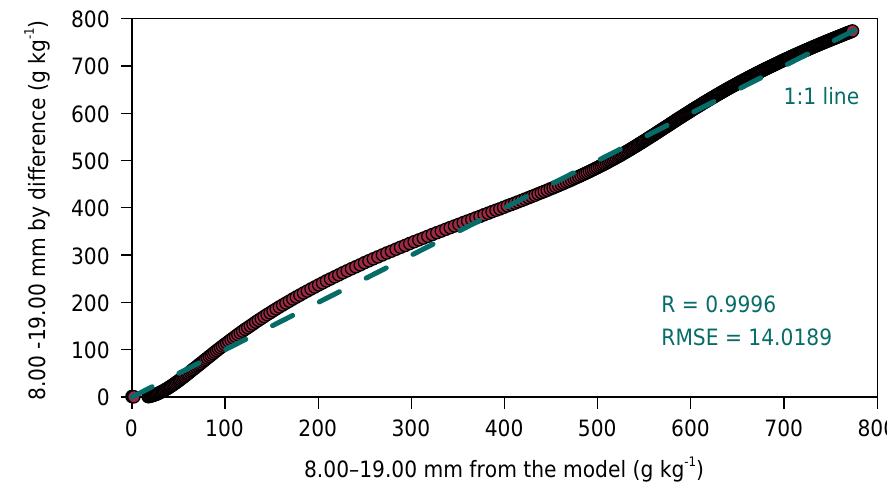
Figure 2. Relationship between the mass of the 8.00–19.00 mm class estimated from the model (Figure 1g) and calculated by difference.